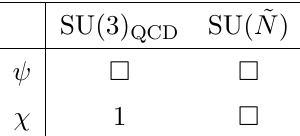
Table 2 . The massless quark content that gives an approximate SU(4) L (cid:2) SU(4) R chiral symmetry broken by the chiral condensate. Interactions with QCD explicitly break the SU(4) (cid:13)avor symmetry. where Q a = Q a (cid:17) Q a is a 4 (cid:2) 4 matrix with the top left 3 (cid:2) 3 submatrix given by SU(3) L R